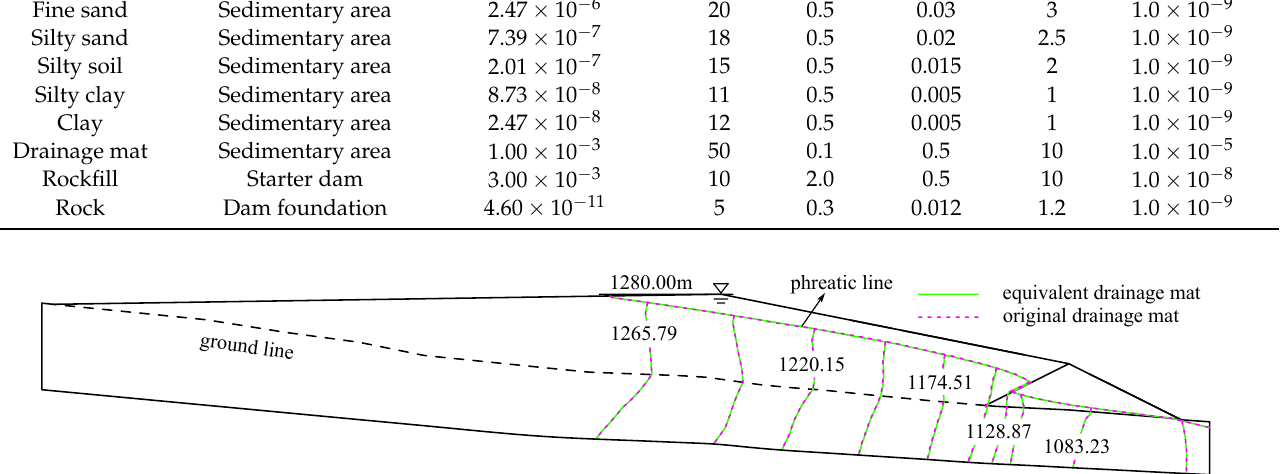
Figure 11. The water potential distributions (m) in the tailings dam with equivalent and original drainage structures when the permeability of equivalent drainage structure is 1.0 × 10 − 4 m/s. The plot suggests the water potential distributions in the tailings dam with the equivalent and original drainage structures are consistent.